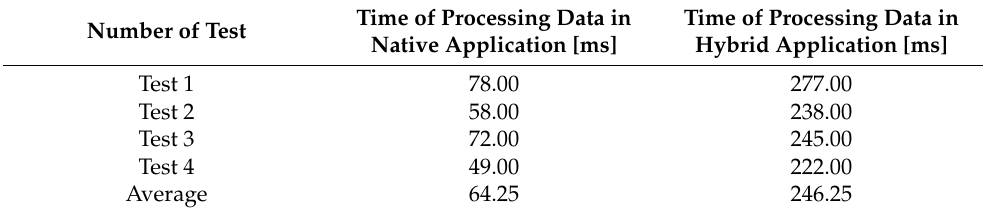
Table 6. Time taken to process the data from REST API (response with 100 objects). Time of Processing Data in Time of Processing Data Number of Test Native Application [ms]